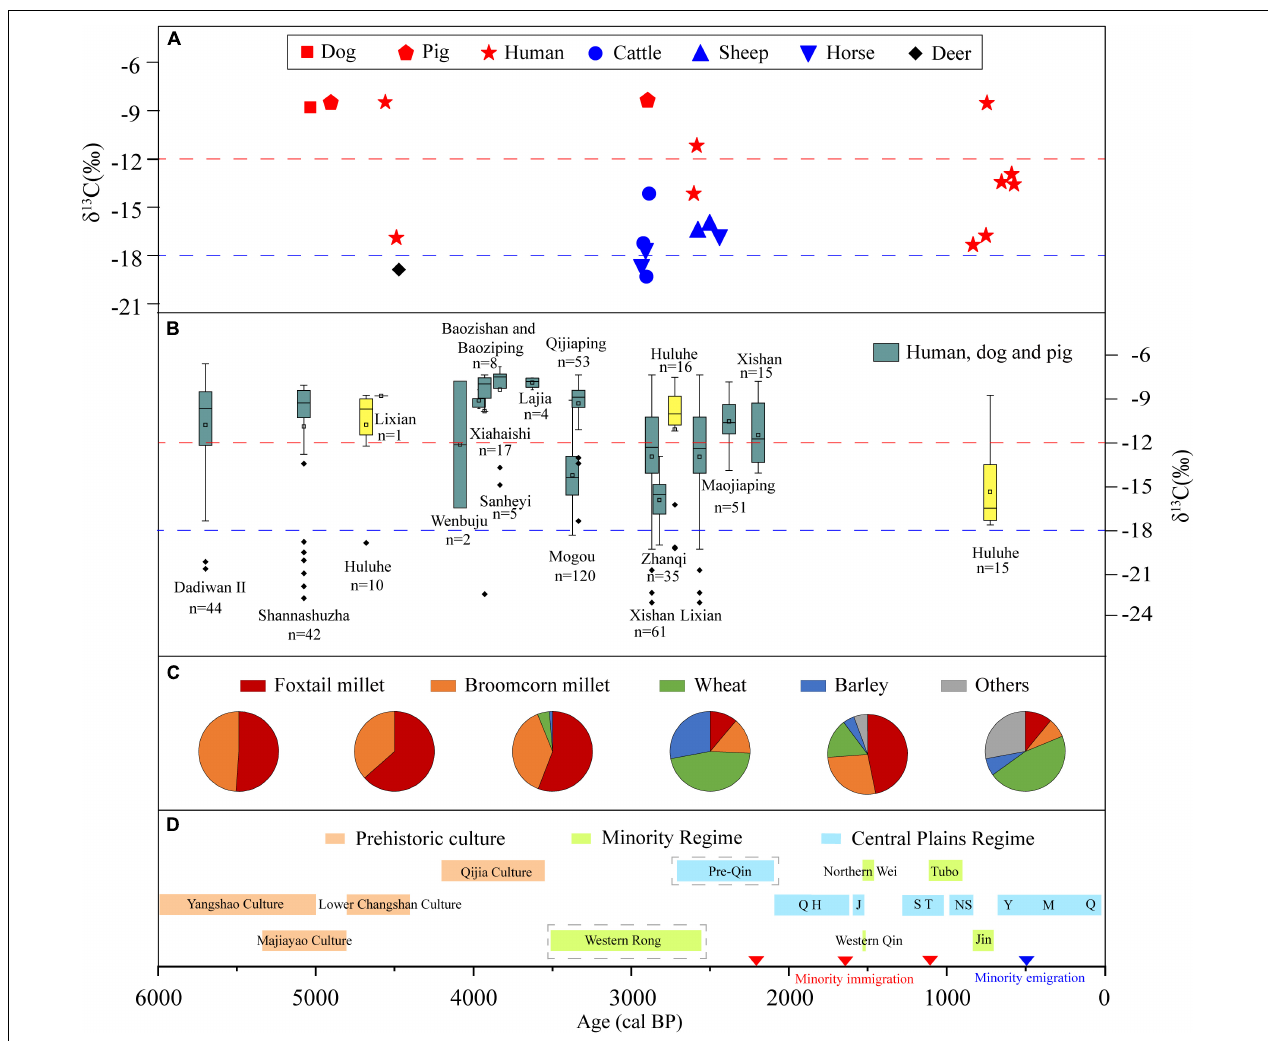
FIGURE 4 | Comparison of isotopic and archaeobotanical results in the middle-lower HRV and WLP. (A) Carbon isotopic results with 14 C dates from sites in the middle-lower HRV. (B) The δ 13 C values from sites in the WLP (yellow boxes represent the site in the middle-lower HRV) (Cai and Qiu, 1984; Barton et al., 2009; Ling, 2010; Ma, 2013; Atahan et al., 2014; Liu et al., 2014; Ma Y. et al., 2016; Zhang et al., 2016; Ren, 2017; Wang Y. et al., 2019). (C) The weight percentage of crops in the WLP (Liu et al., 2004; Yang, 2014; Hu, 2015; Li, 2018; Chen et al., 2019, 2020; Ren et al., 2021). (D) Regime change between Han and Minority and events of Minority immigration and emigration (Li et al., 1993; Local Chronicle Compilation Committee of Zhuanglang County, 1998; Local Chronicle Compilation Committee of Qin’an County, 2001; Xie, 2002; Local Chronicle Compilation Committee of Tianshui City, 2004; Local Chronicle Compilation Committee of Pingliang City, 2011; Wang, 2012; Local Chronicle Compilation Committee of Gansu Province,